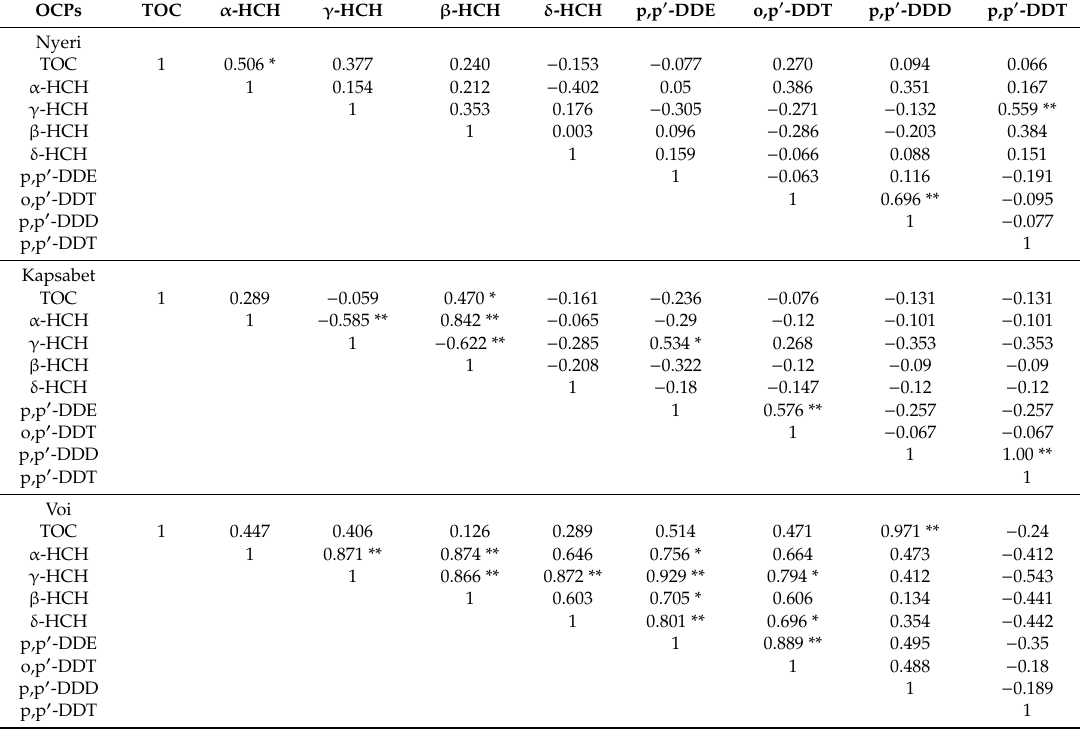
Table 4. Pearson correlation matrix illustrating the TOC, DDTs, and HCHs concentrations, in suburban soils from Nyeri, Kapsabet, and Voi towns.